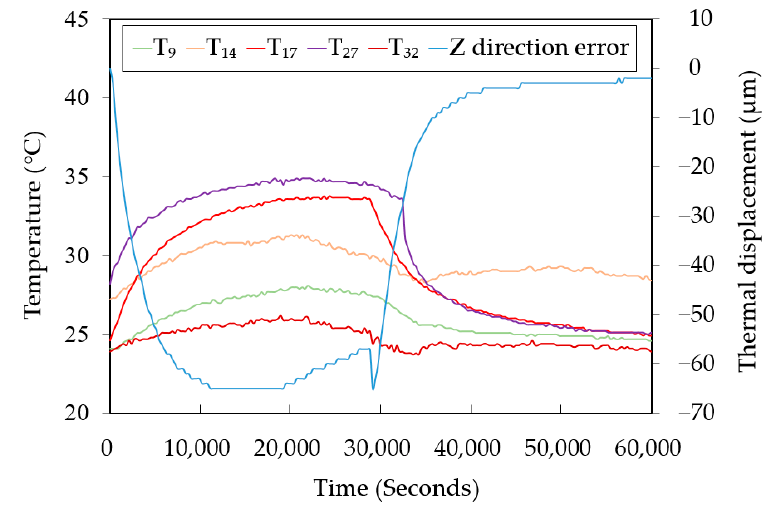
Figure 8. Trend analysis of five KTP temperatures and spindle displacement.